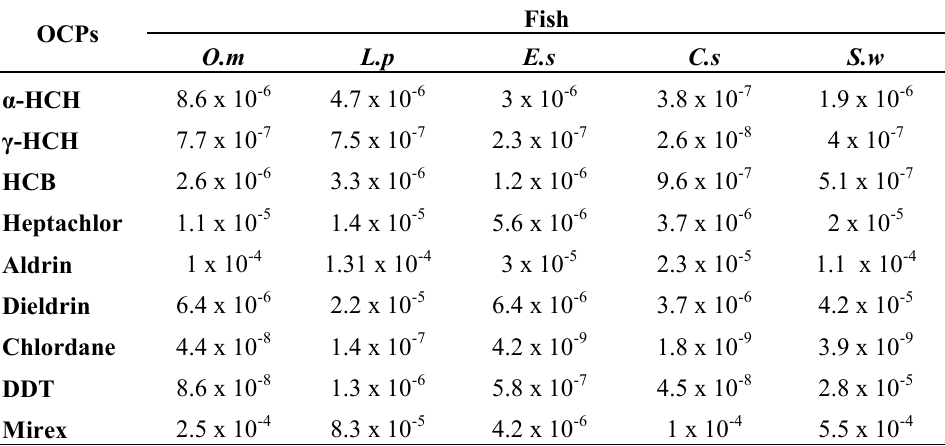
Table 2. Carcinogenic Risk (CR) of OCPs through fish from River Cauvery. OCPs